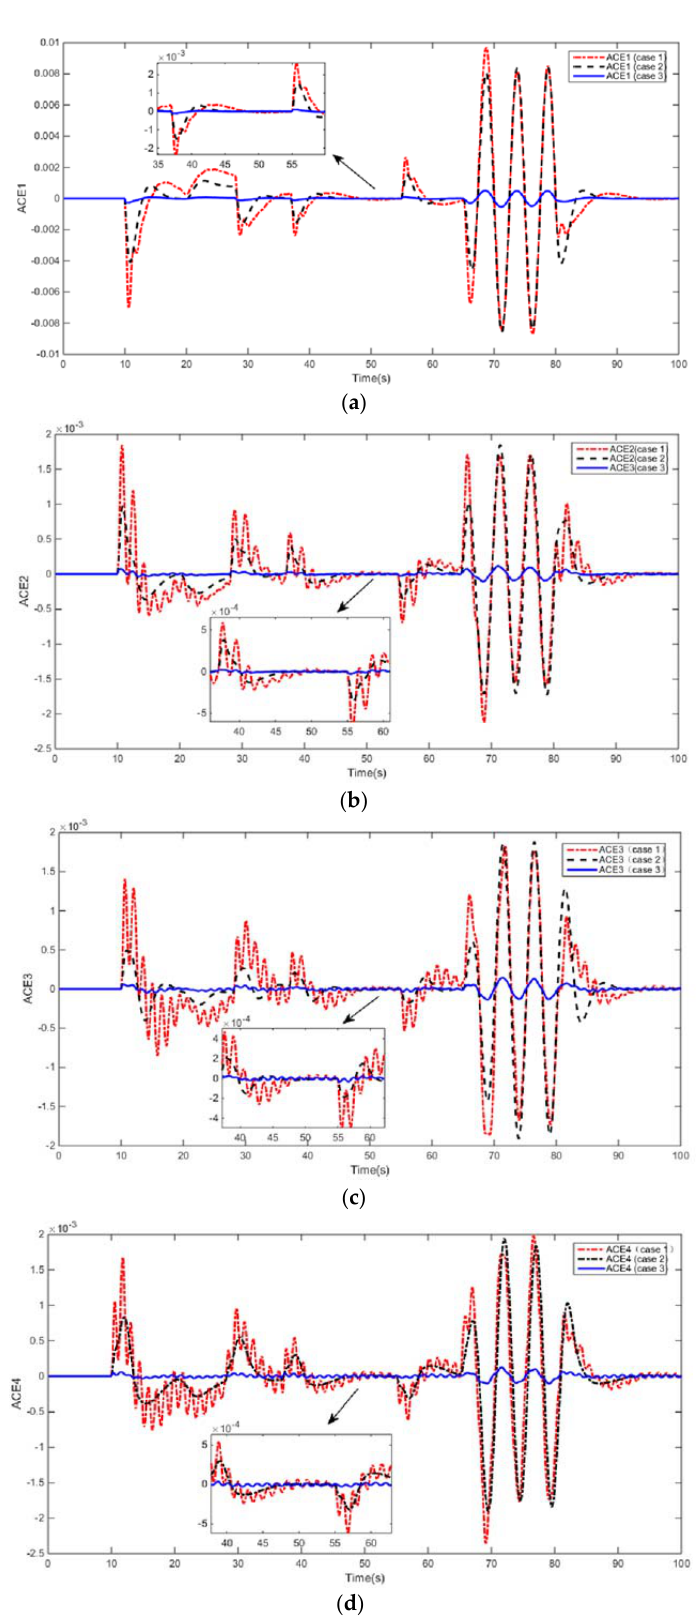
Figure 10. ( 1,2,3,4) i ACE i  of each control area under load disturbance in three different cases: ( a ) Figure 10. ACE i ( i = 1,2,3,4 ) of each control area under load disturbance in three different cases: ACE of Control Area 1; ( b ) ACE of Control Area 2; ( c ) ACE of Control Area 3; and ( d ) ACE ( a ) ACE 1 of Control Area 1; ( b ) ACE 2 of Control Area 2; ( c ) ACE 3 of Control Area 3; and ( d ) ACE 4 of 1 2 3 4 Control Area of Control Area 4.